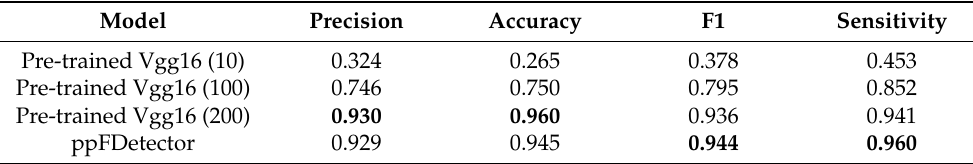
Table 3. Performance comparison with fully supervised model.